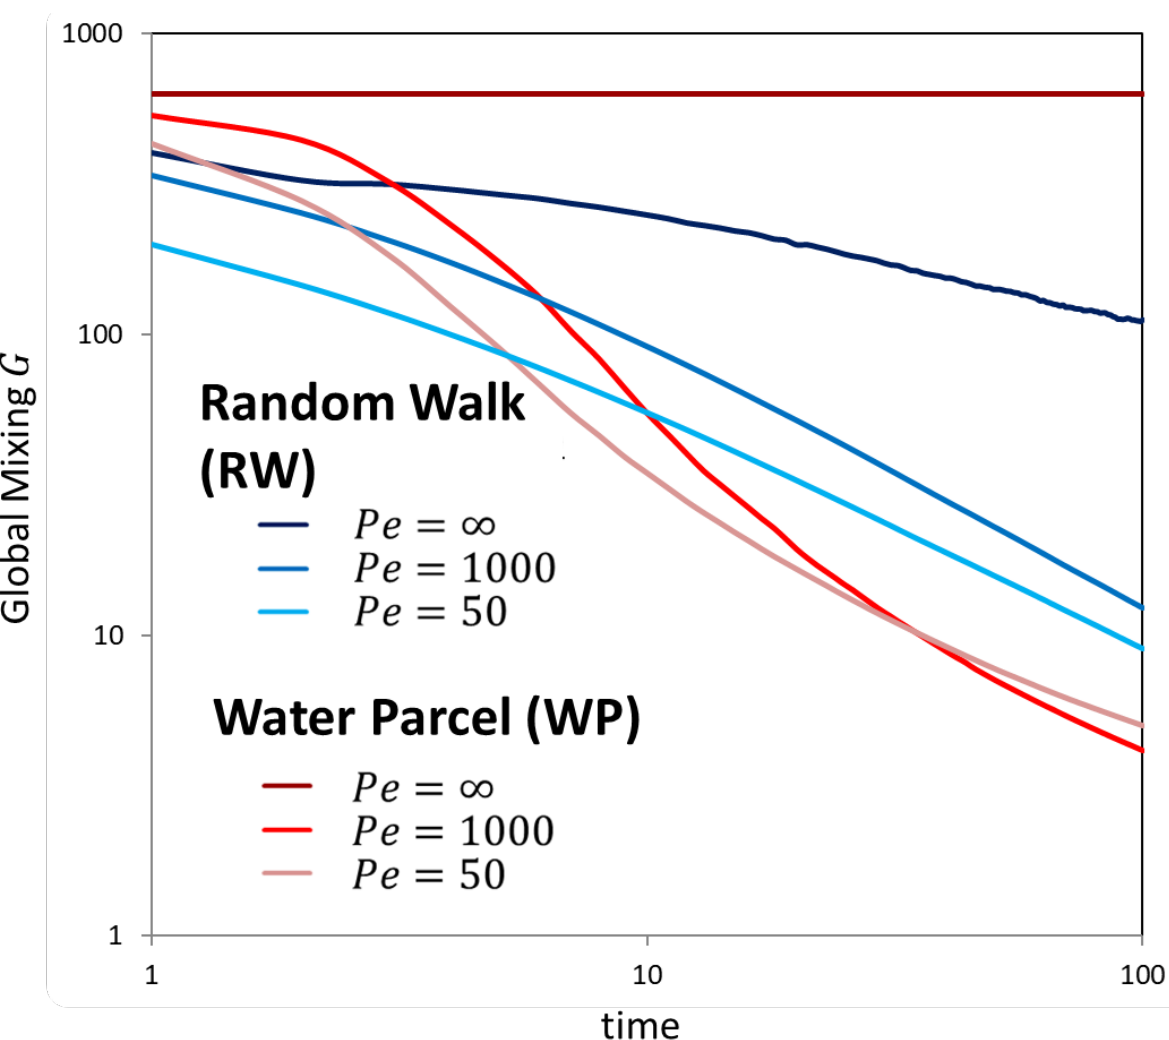
Figure 6. Temporal evolution comparison of the global mixing state between the random walk and water parcel methods = 1 heterogeneity σ 2 Y at 𝜎 𝑌2 = 1 heterogeneity level.